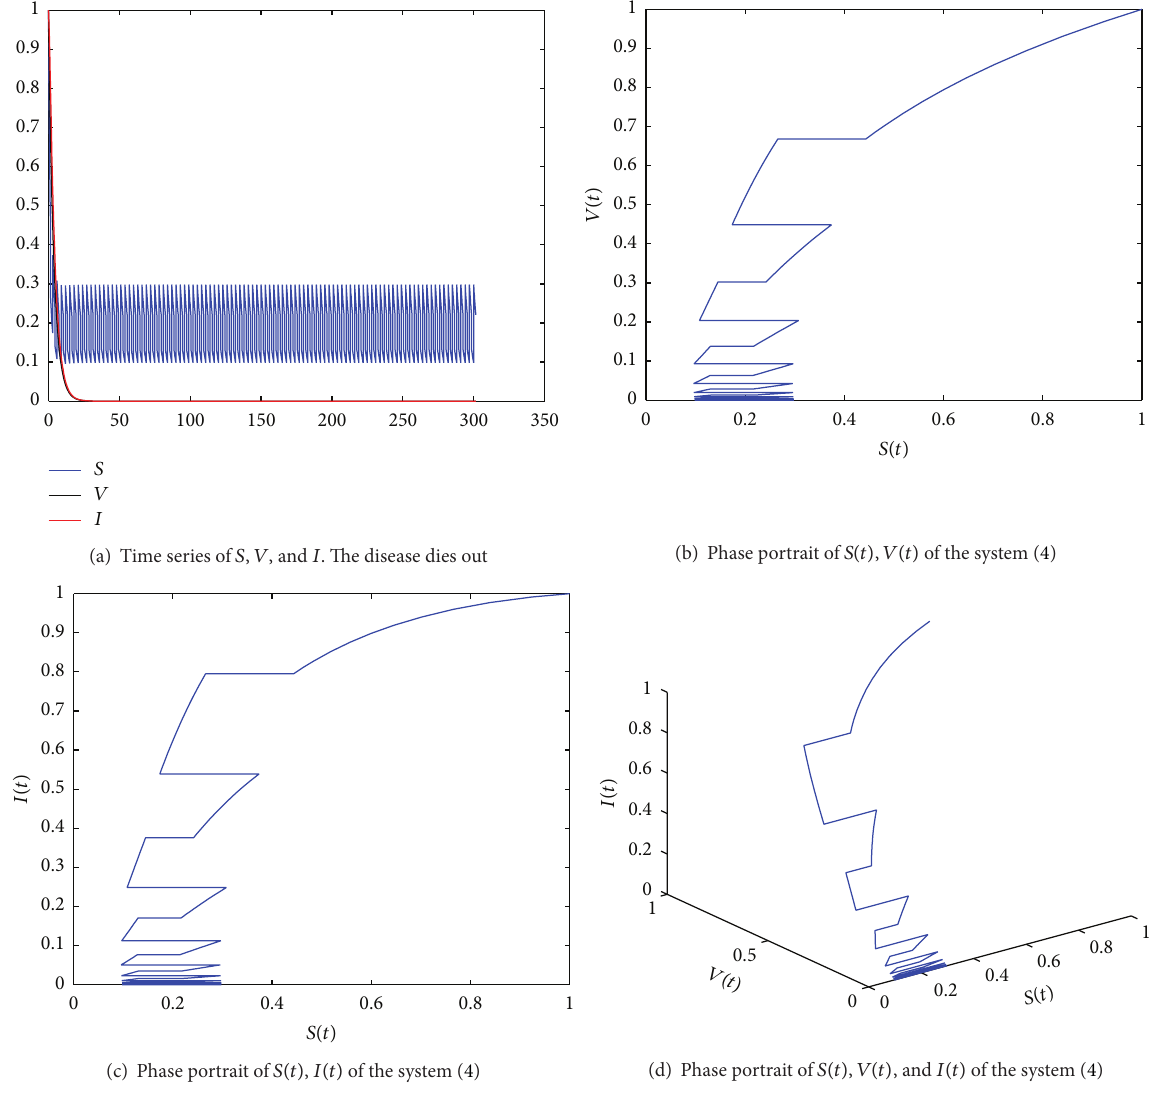
Figure 4: The results of numerical simulation on the threshold values R 1 = 0.0352 < 1 , where 𝑝 = 1.5 , 𝑞 = 1.25 .